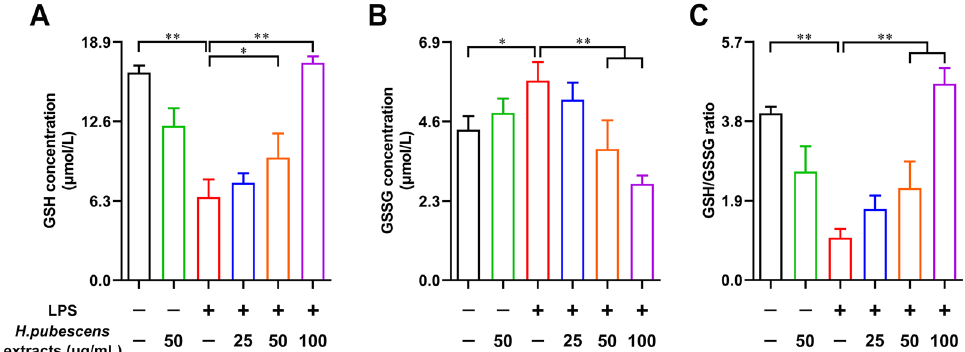
Figure 3. H. pubescens extracts regulated the intracellular GSH, GSSG, and GSH/GSSG ratio in LPS- irritated DCs. DCs were collected and washed with PBS after being cultured with the designed con- centrations of H. pubescens extracts or plus LPS (100 ng/mL) for 24 h. Then, DCs were lysed to detect the GSH content ( A ), the GSSG content ( B ), and the GSH/GSSG ratio ( C ) using a commercial kit. All of the data are shown as means ± SD from three experiments. Analysis of variance (ANOVA) was employed. ** p < 0.01, * p < 0.05.